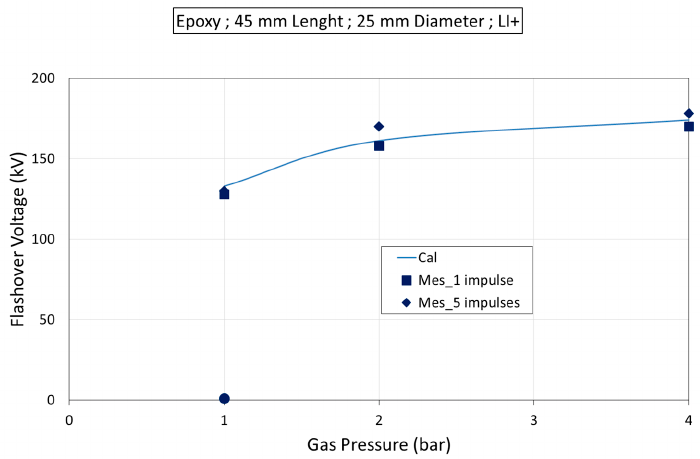
Figure 11. Comparison between calculated and measured flashover voltage versus gas pressure for insulator 2 with 60 mm length and 25 mm diameter. insulator 2 with 60 mm length and 25 mm diameter.